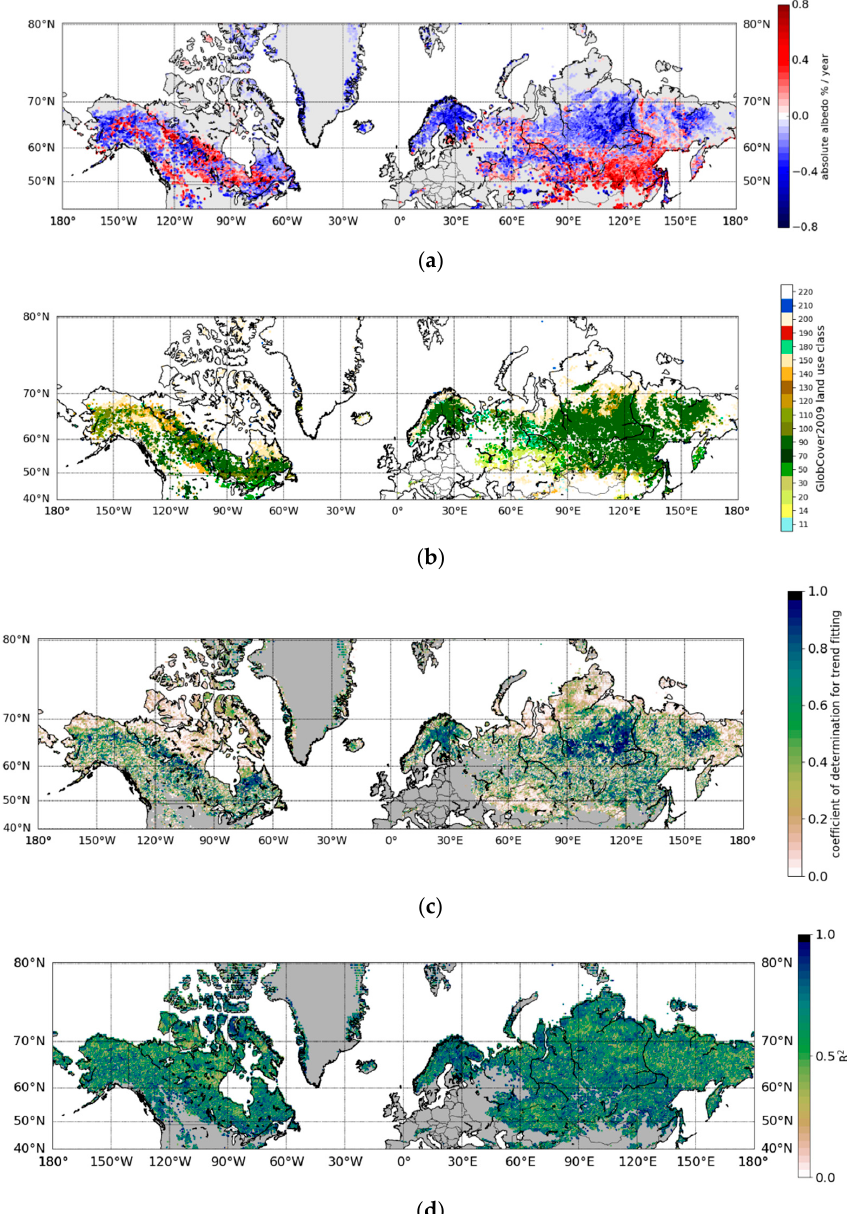
Figure 4. ( a ) The rate of change in albedo before melt season (absolute albedo % per year) between 1982 and 2015 using 5 year rolling mean albedo (showing cases for which R 2 of the fitting was larger than 0.5). The positive rates of change mean higher albedo and negative lower albedo values. ( b ) The GlobCover land-use class for the areas with clear trends in pre-melt albedo. ( c ) The coefficient of determination ( R 2 ) value for trends in albedo before the onset of melt. ( d ) R 2 value for multiple variable linear correlation between albedo before melt season and 6 climatic parameters for 14 days prior onset of melt. The climatic parameters used are the mean air temperature, number of days with maximum temperature above 0 °C, − 4 °C and − 10 °C, accumulated precipitation and mean wind speed.